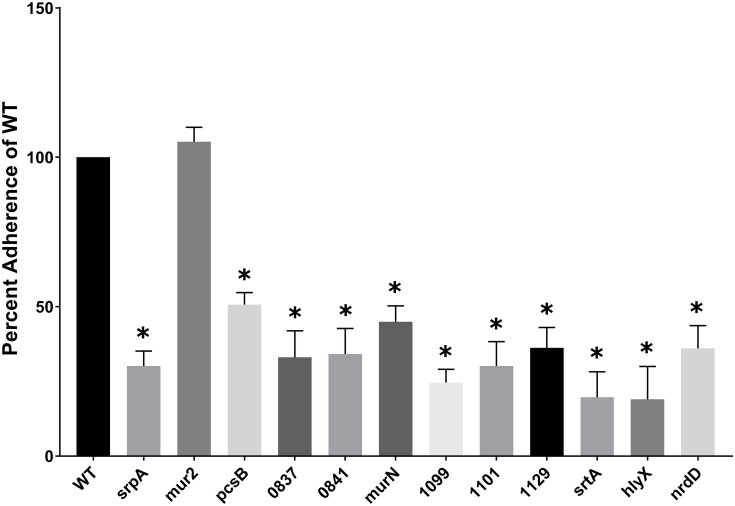
S. sanguinis mutants with a deficiency in human platelet binding. Adherence of purified platelets to immobilized bacteria. Microtiter wells were coated with a normalized concentration of bacterial cells and then blocked with BSA. Platelets resuspended in Tyrode’s buffer were added to the wells and incubated at 37°C to allow adhesion. Bound platelets were lysed in the presence of pNPP and the optical density at 410 nm measured. The ability of each strain to bind platelets was indirectly determined by quantitation of platelet acid phosphatase activity as measured by nitrophenol production from pNPP. Mutant strain platelet binding was compared to WT. Assays were performed in triplicate and three experiments were performed. Statistical analysis was performed using one-way ANOVA and corrected for multiple comparisons against the WT mean using Dunnett’s test. ∗p < 0.05. Error bars represent the standard error.